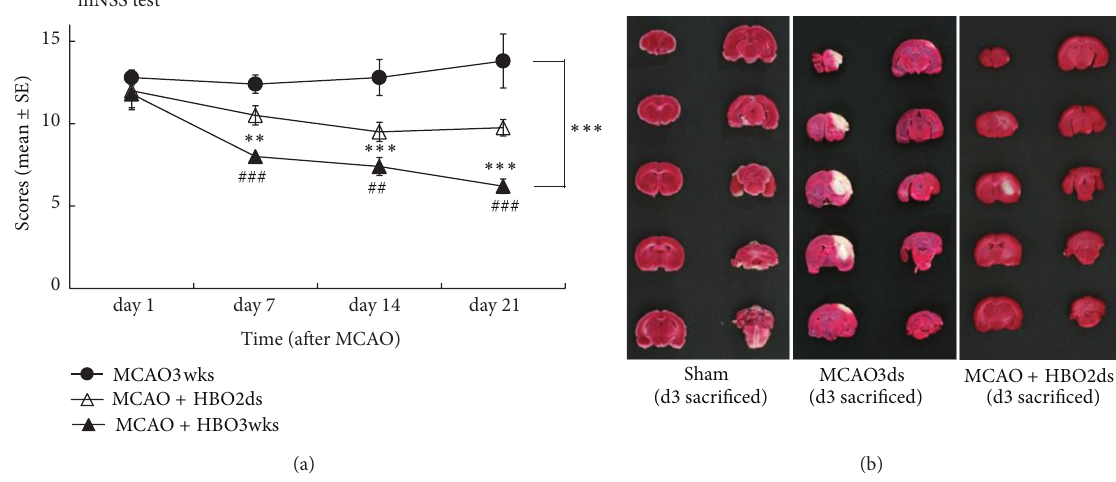
Figure 2: Long course HBO improved functional outcome and decreased infarction size. (a) Behavior tests showed HBO significantly improved function outcome with dose-dependent effect. The mNSS in groups received HBO therapies is significantly less than that in control group ( ∗∗∗ 𝑃 < 0.001 ). The declining curve of mNSS in the HBO3wks group became more obviously after day 14. (b) Infarcted area shown on TTC staining (white color) was prominent in the MCAO group but decreased in HBO treated